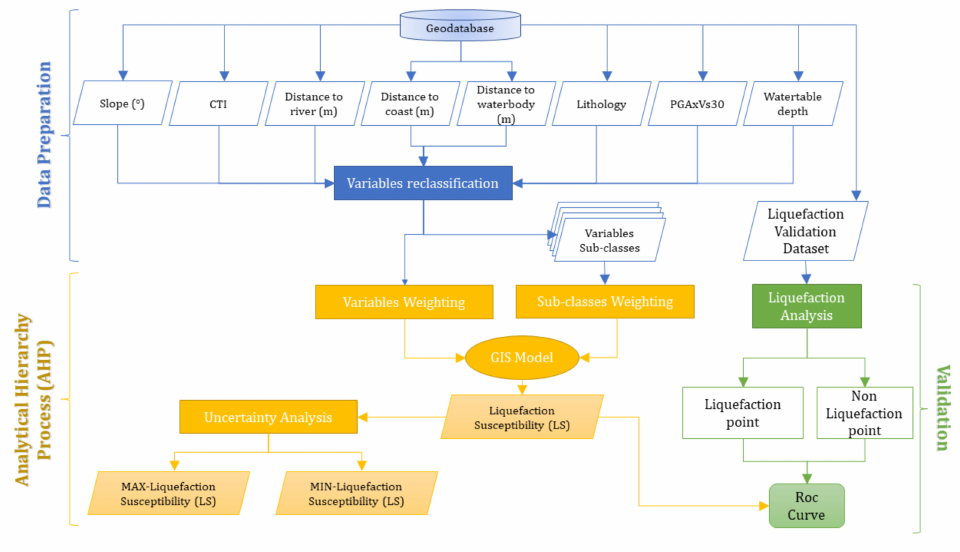
Figure 2. Flow-chart of the method